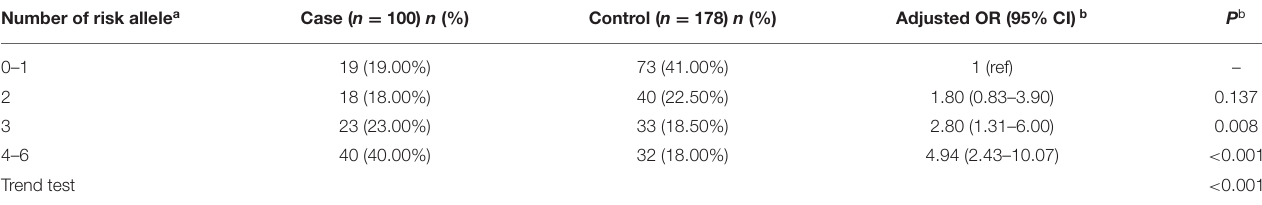
TABLE 5 | Joint effect of 3 significant SNPs on MPP risk. Number of risk allele